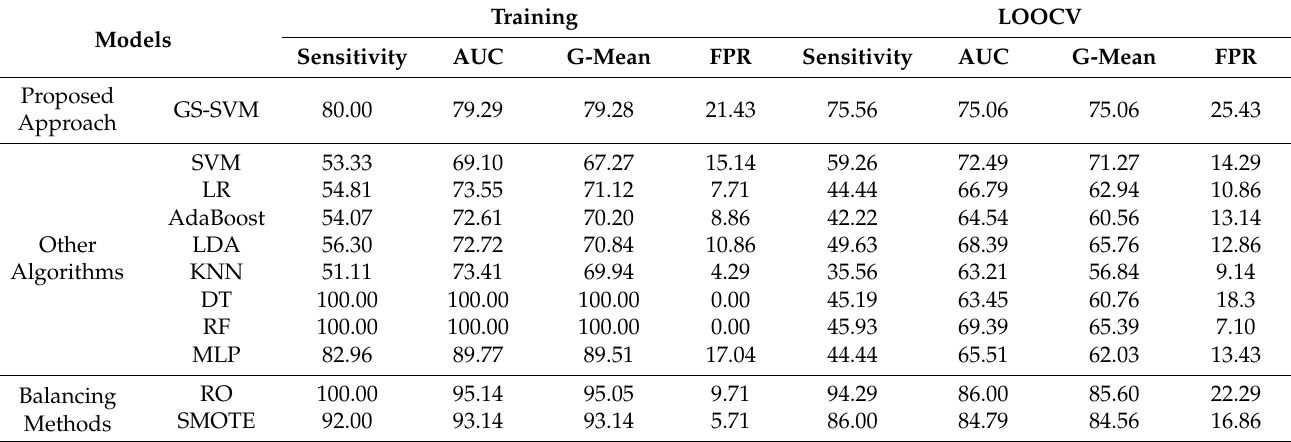
Figure 8. Results for GS-SVM vs. other methods in terms of performance metrics (phase 2). Table 5. Phase 2 results (training and